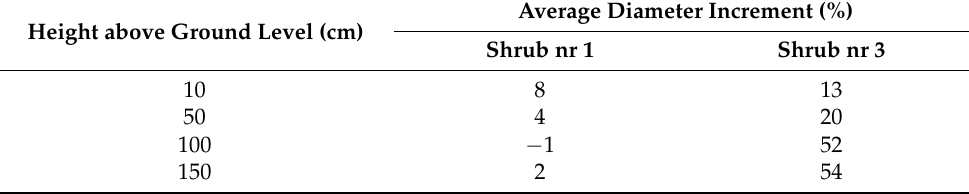
Table 4. Summary of changes in mean diameters of shrubs 1 and 3 between the 2020 and 2021 vegetation